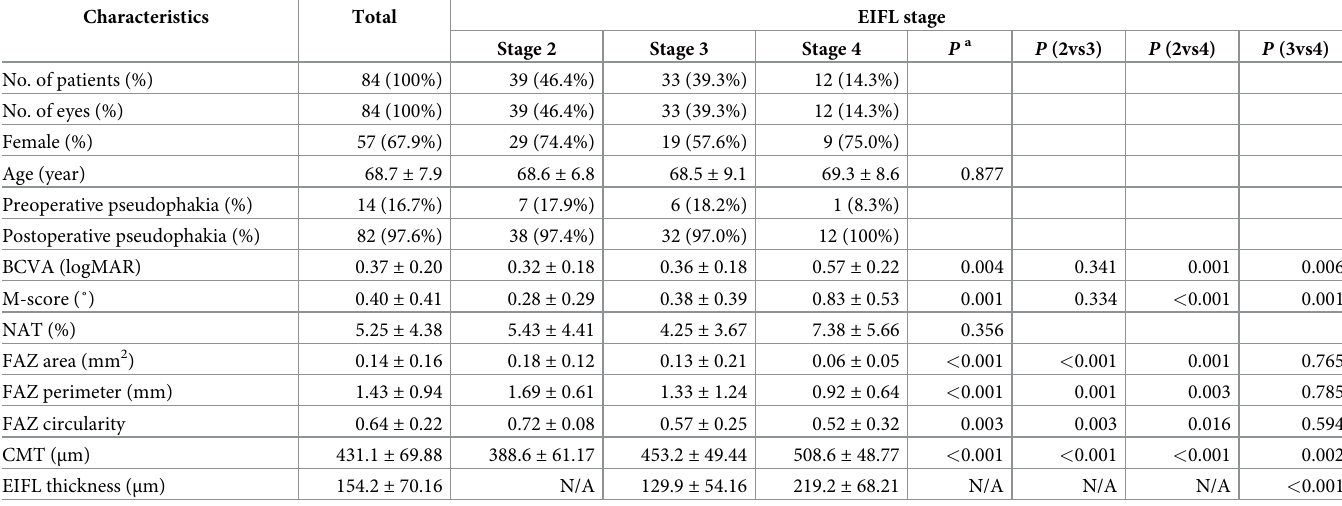
Table 1. Demographics and clinical data of patients with idiopathic epiretinal membrane.